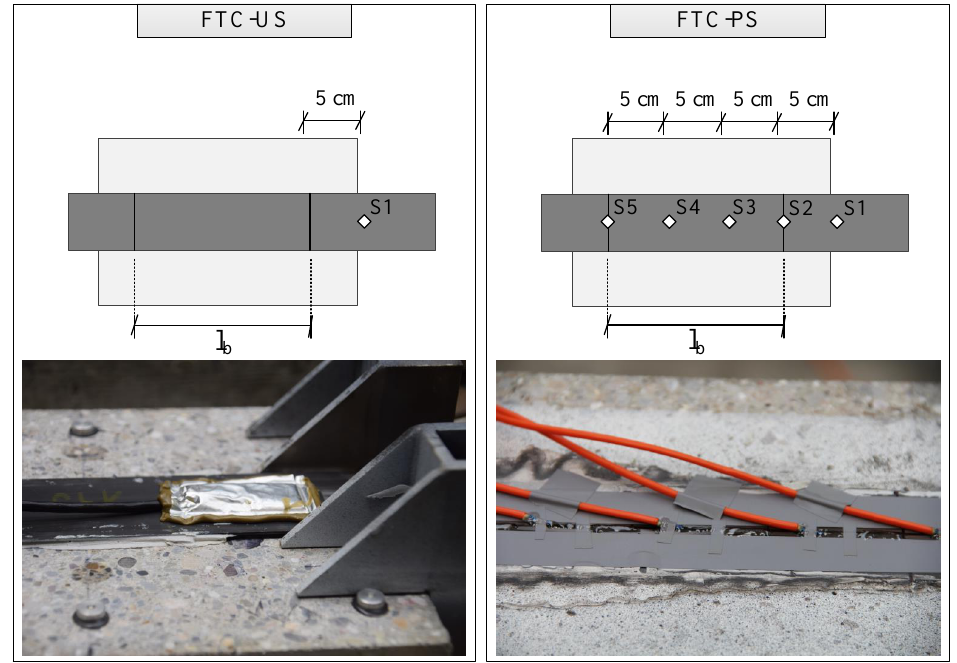
Figure 4. Left : Conventional strain sensor placed at the free-length for unstressed blocks; right : fiber optic strain sensors placed at the free-length and along the bonded region for prestressed